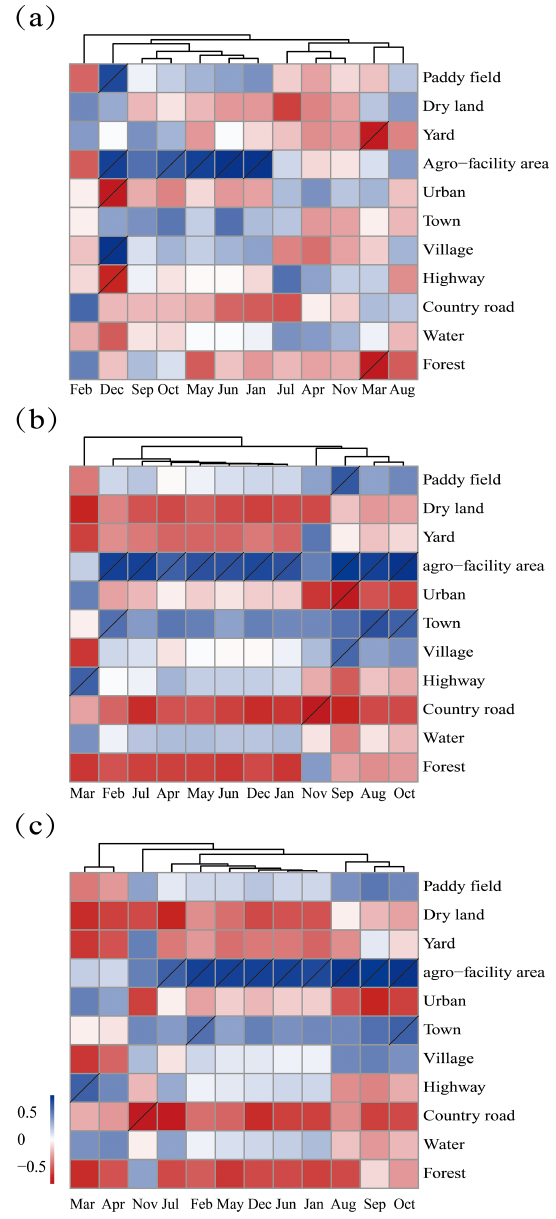
Figure 6. Pearson’s correlation between monthly wet (a) , dry (b) and total (c) fluxes and areas of different land-use types. Gray slash indicates significance at p< 0 .